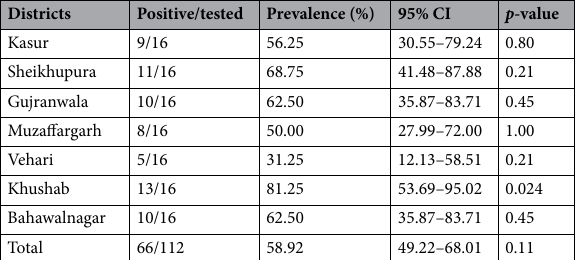
Table 3. Farm level seroprevalence of Q fever in ruminant farms in Punjab, Pakistan.